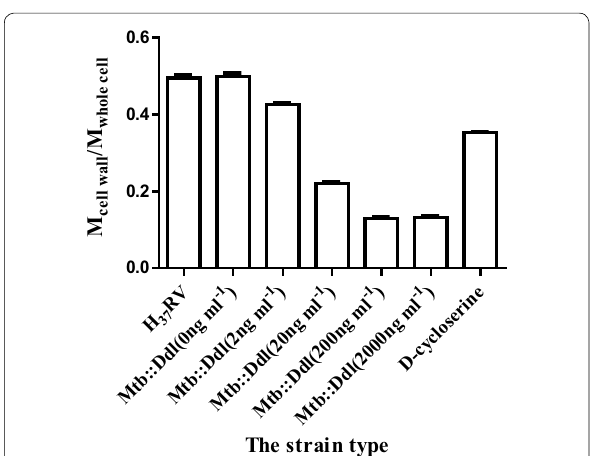
Fig. 3 The proportion of the cell wall mass to the whole cell